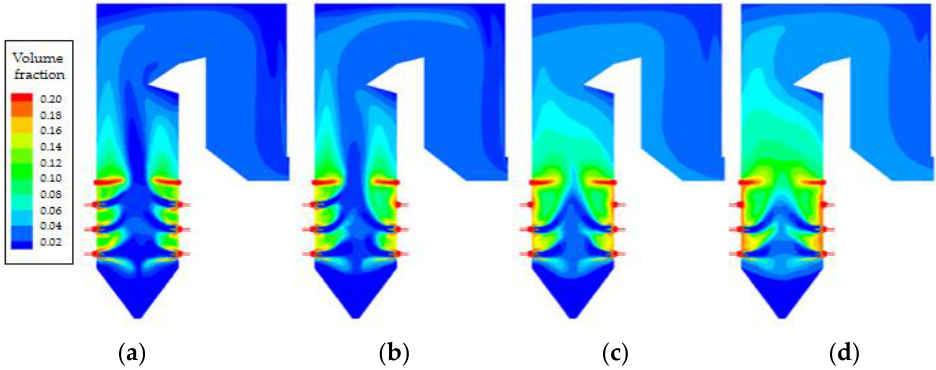
Figure 6. Distribution of O 2 volume concentration under different loads: ( a ) Distribution of O 2 volume concentration under 600 MW boiler load; ( b ) Distribution of O 2 volume concentration under 500 MW boiler load; ( c ) Distribution of O 2 volume concentration under 400 MW boiler load; ( d ) Distribution of O 2 volume concentration under 250 MW boiler load.